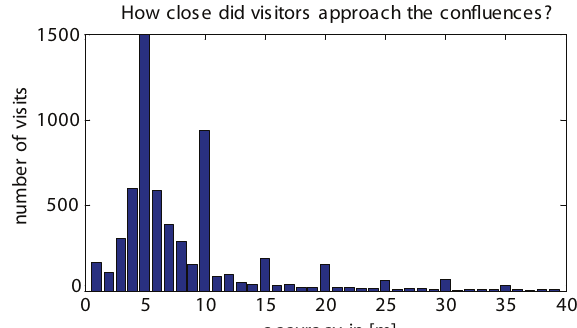
Fig. 11. Reported minimal distances. Distances over 40m are not shown. The median is 7 m, the average